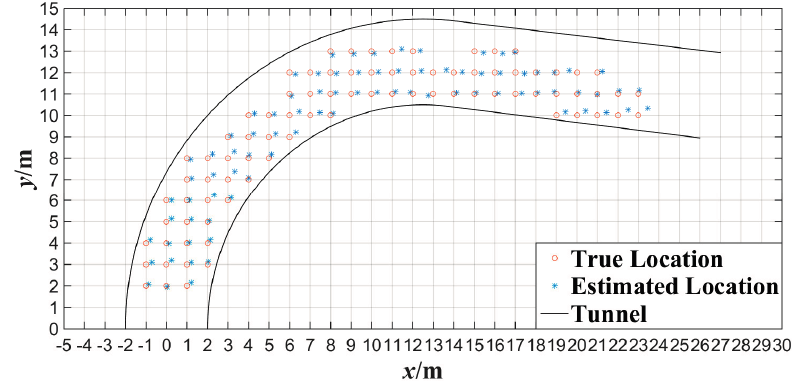
Figure 14. Experimental data of plane localization with the miner’s lamp video collaborative localization.